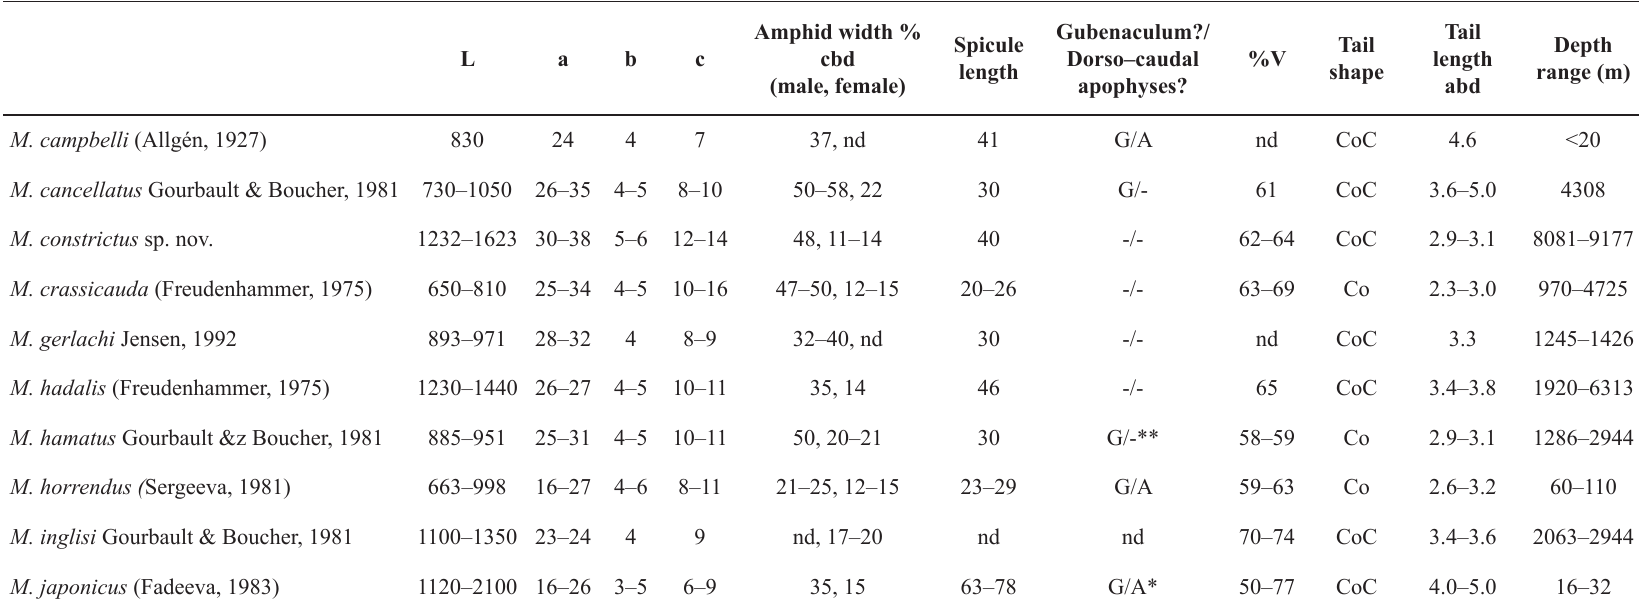
Table 2. Key morphological characteristics of all valid Metasphaerolaimus species, and their bathymetric distribution. A: dorso-caudal apophyses present; co = conical; coc = conico-cylindrical; G = gurbernaculum present; nd = no data; - = absent. Depth range data based on type locality and additional distribution data summarised by Jensen